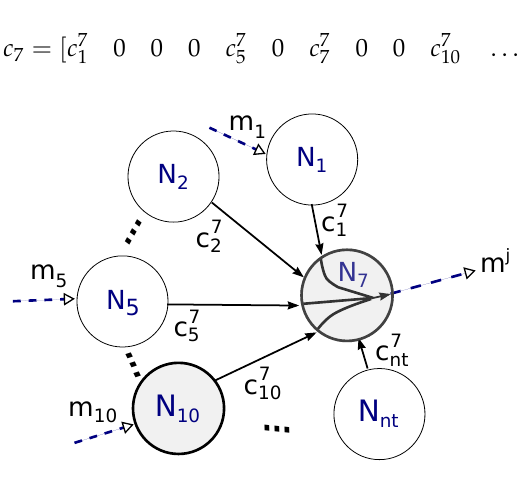
Figure 4. Example of coded